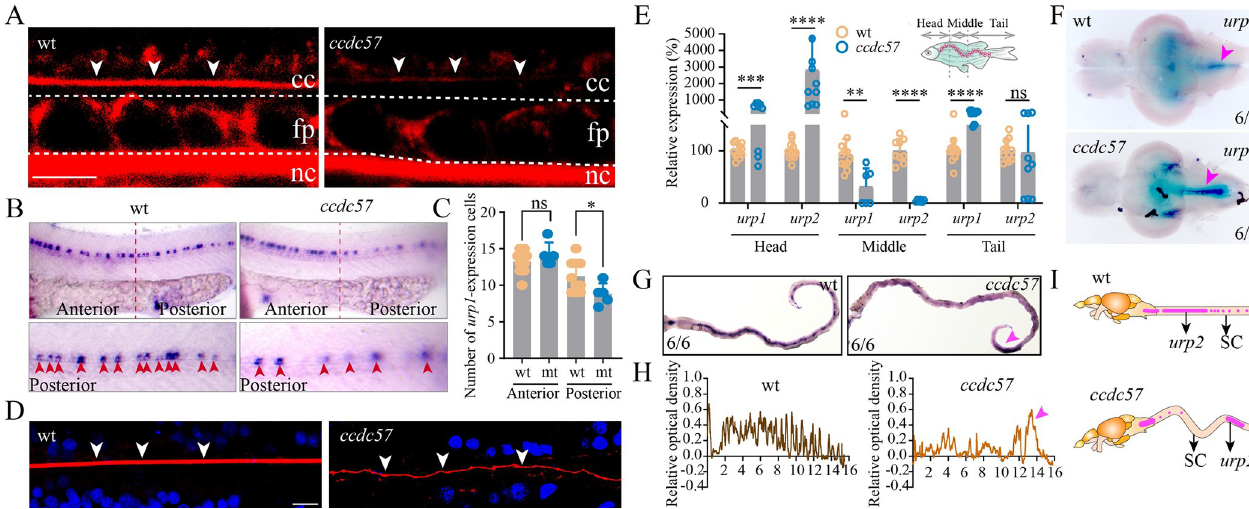
Fig 7. Mutation of ccdc57 results in RF defects and abnormal expression of Urotensins in the spinal cord. ( A ) Representative images of Reissner fiber (RF, white arrows) in 2 dpf wild type and ccdc57 mutant larvae. cc, central canal; nc, notochord; fp, floor plate. ( B ) Whole-mount in situ hybridization results showing the expression of urp1 in 24 hpf control and ccdc57 mutant larvae as indicated. The enlarged views of the staining in the posterior region are shown in the bottom. ( C ) Statistical analysis showing the number of urp1 -expressing cells in the anterior and posterior part of the trunk. ( D ) Confocal images showing RF (white arrow) in wild type and ccdc57 adult mutants. RF was stained with wheat germ agglutinin (WGA, red), and nuclei were counterstained with DAPI. ( E ) qPCR analysis showing the expression of urotensin genes ( urp1 and urp2 ) in different parts of the adult trunk as illustrated in the diagram. ( F ) In situ hybridization results showing the expression of urp2 in the brains of adult wild type and ccdc57 mutant as indicated. Arrows point to the expression of urp2 in the posterior part of the brain. ( G ) In situ hybridization results showing the expression of urp2 in the spinal cord of wild type and ccdc57 mutant as indicated. The purple arrowhead indicates the sites of enriched urp2 expression. ( H ) The line graphs showing the relative optical density of the expression of urp2 in wild type and ccdc57 mutants. ( I ) Model illustrating the distribution of urp2 in wild type and ccdc57 mutant. Scale bars: 7.5 μ m in panel A; 10 μ m in panel D. The data underlying the graphs shown in the figure can be found in S1